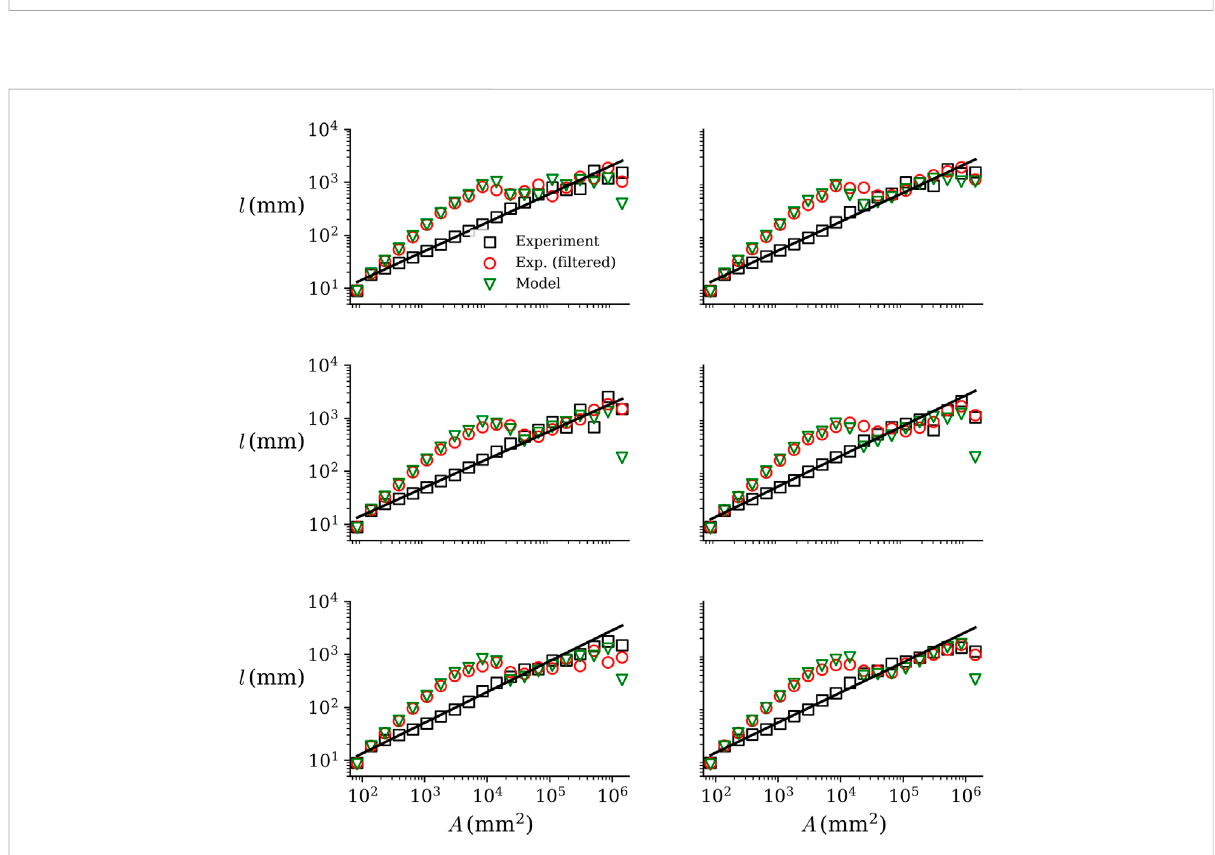
FIGURE 10 Relation between the upstream length and drainage area (Hack ’ s law) for the model and experiment. The model results differ from the (un fi ltered) experimental data, but agrees with the experimental data subjected to the low-pass fi lter.